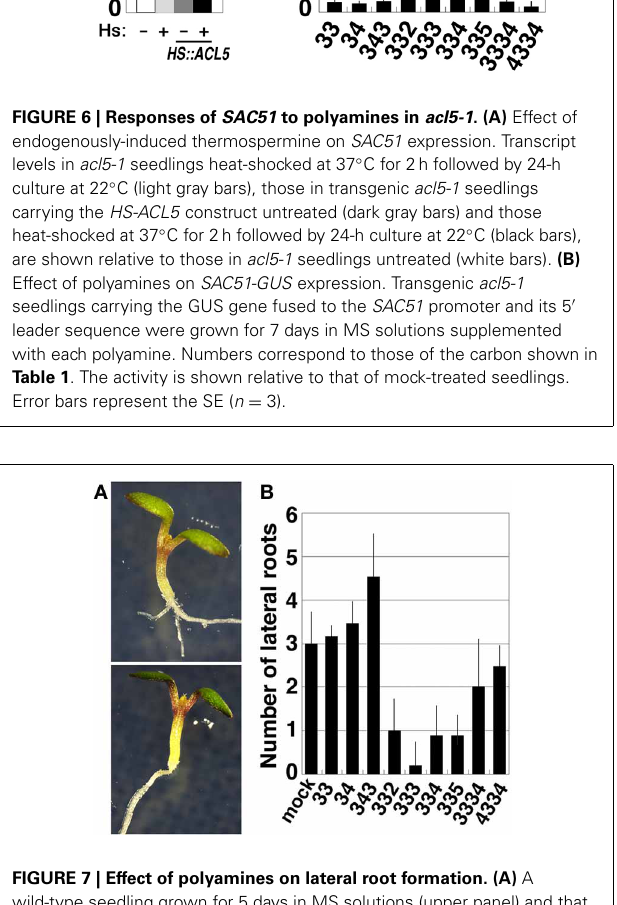
target of MP/ARF5 (Donner et al., 2009; Schlereth et al.,